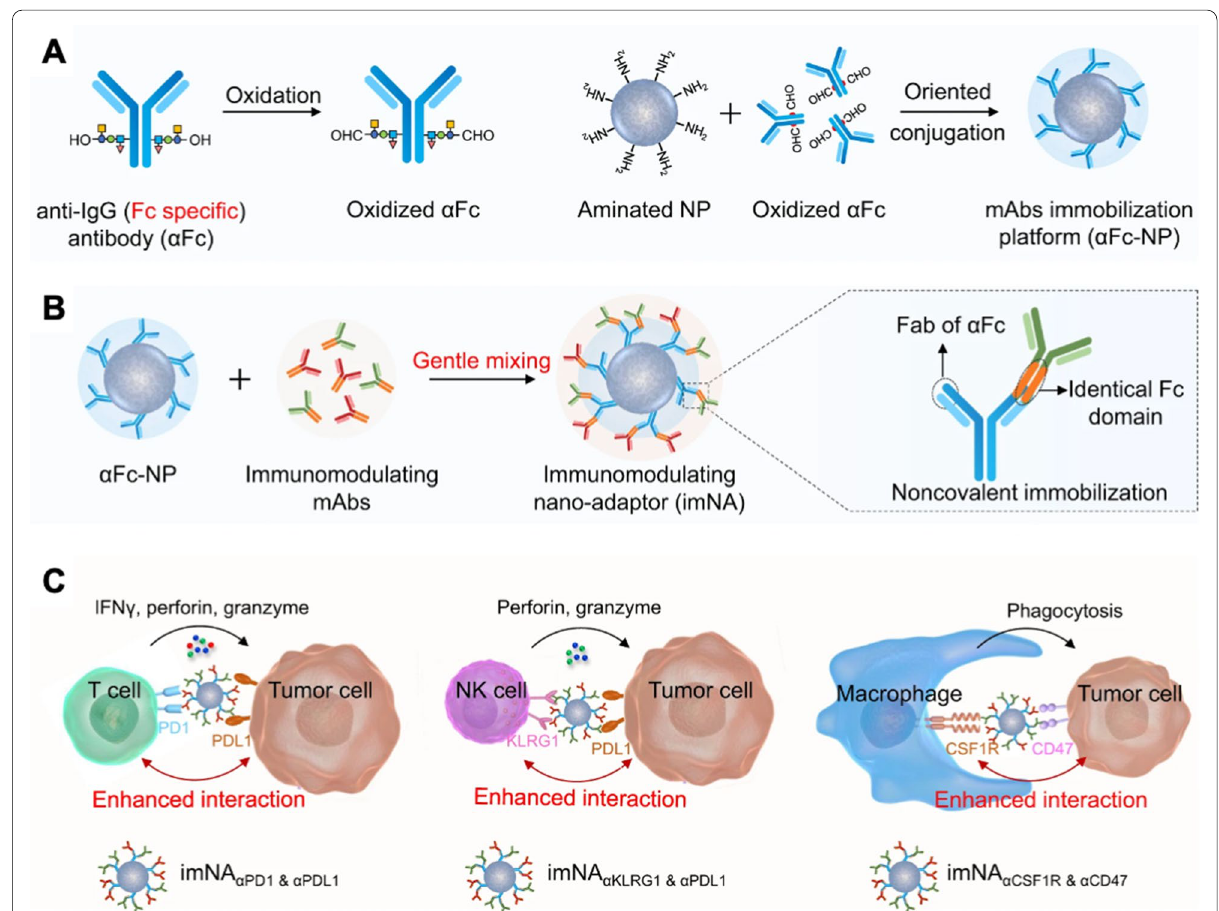
Fig. 7 A Conjugation of an anti-IgG (Fc specific) antibody (αFc) to nanoparticle (αFc-NP). B Two types of immunomodulating monoclonal antibodies (mAbs) targeting effector cells and tumor cells immobilized onto αFc-NP to create immunomodulating nanoadaptors (imNA). C imNAs were validated in T cell-, natural killer cell- and macrophage-mediated antitumor immune responses in multiple murine tumor models. Reprinted with permission, [218] https:// doi. org/ 10. 1038/ s41467- 021-